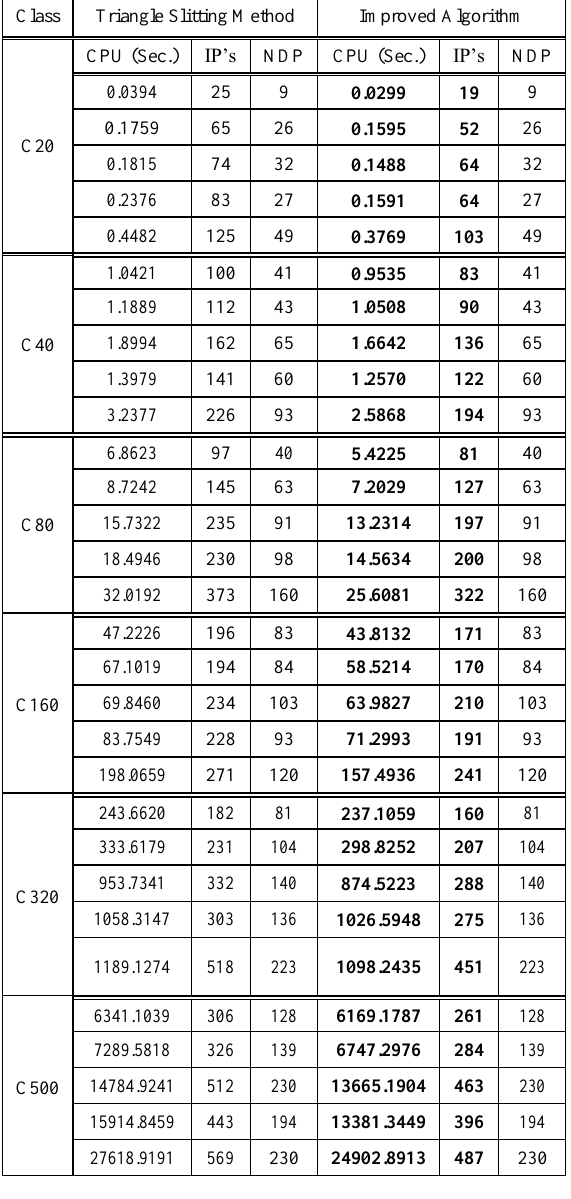
Table 3. Comparison CPU time of TSM and